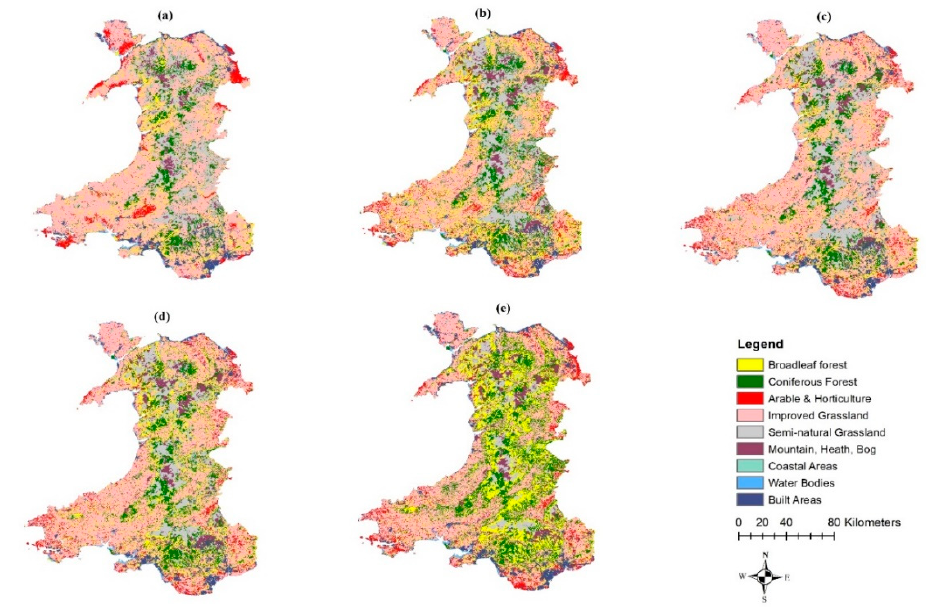
Figure 2. LULC maps of Wales projected to 2030 under a range of scenarios representing possible post-Brexit futures. Maps indicate the effect of Business as Usual (B-a-U, ( a ), Green Future (GF, ( b ), Free Trade Agreement (FTA, ( c ), World Trade Organisation (WTO, ( d ) and Unilateral Trade Liberalisation (UTL, ( e ) scenarios.